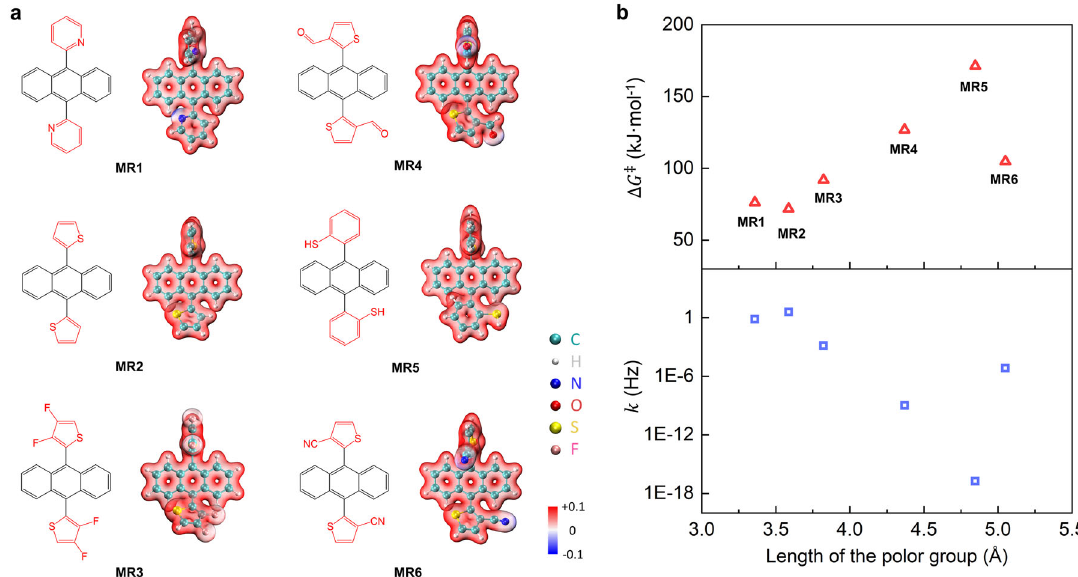
Fig. 1 Free energy barrier of molecular rotors with different polar rotors. a Skeletal formula of molecular rotors ( MR ) 1 – 6 and transition states (TS) with electrostatic potential map. In skeletal formula, the anthracene stator is in black and two co-axial polar rotors connected to anthracene are in red. For each molecular rotor shown in electrostatic potential map, the polar rotor above is in equilibrium and the one below is in TS. b Free energy barrier Δ G ‡ and rotational frequency k for different molecular